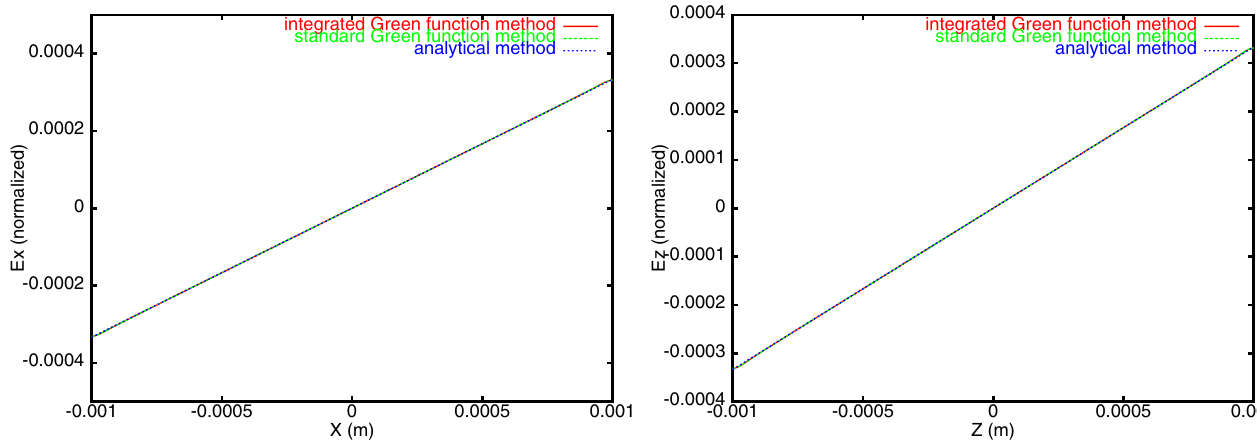
FIG. 4. (Color) Electric fields along x axis (left) and along z axis (right) of a beam with aspect ratio one from solutions of the integrated Green function method, the standard Green function method, and the analytical method.